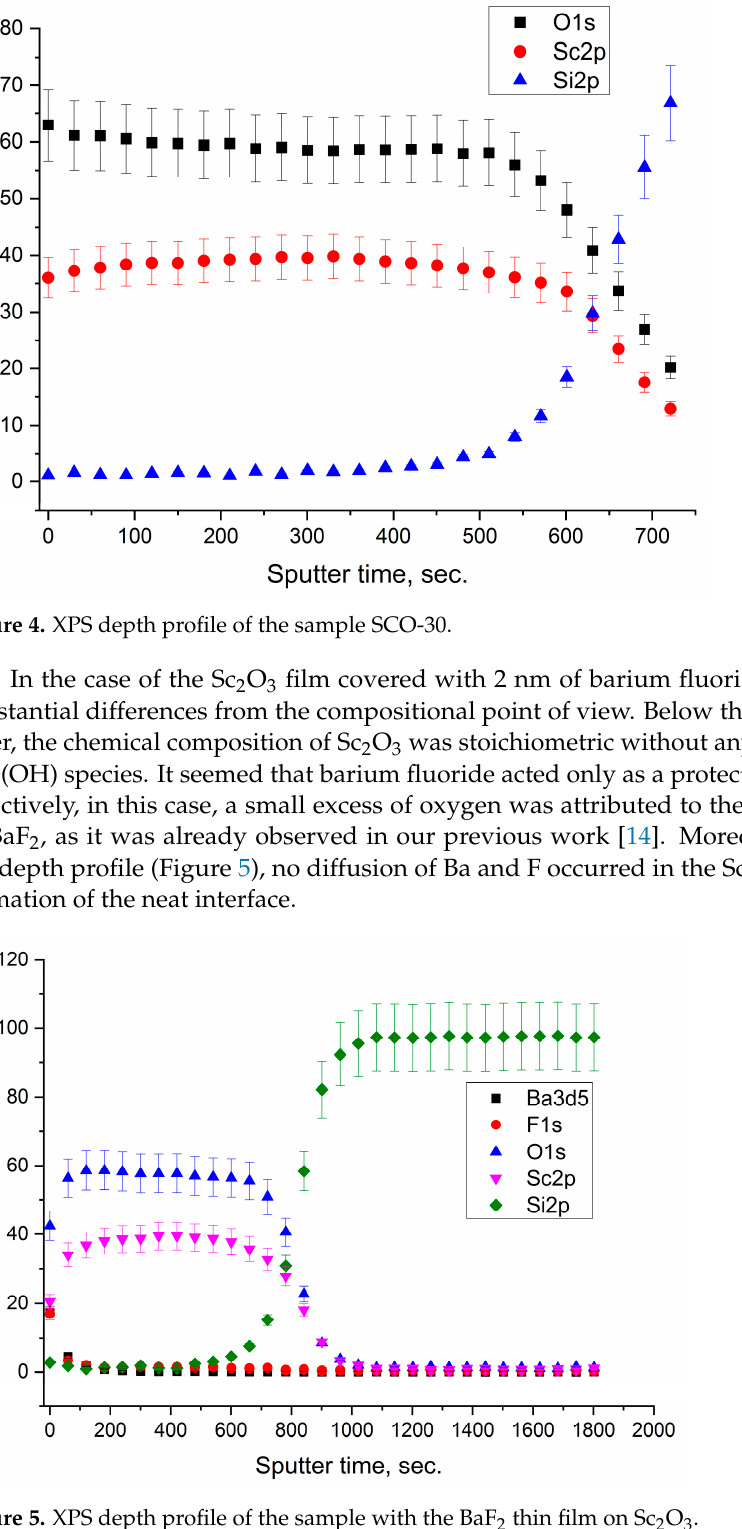
Figure 5. XPS depth pro fi le of the sample with the BaF 2 thin fi lm on Sc 2 O 3 .